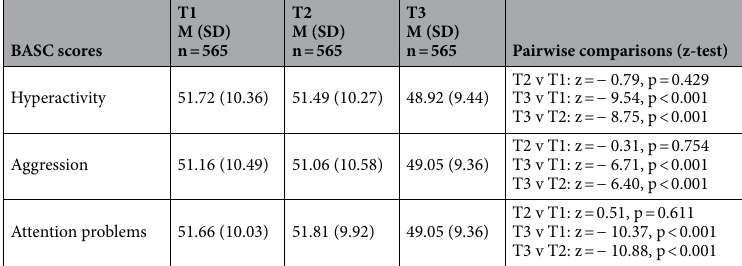
Table 1. Differences in BASC scores between the waitlist and active ENGAGE